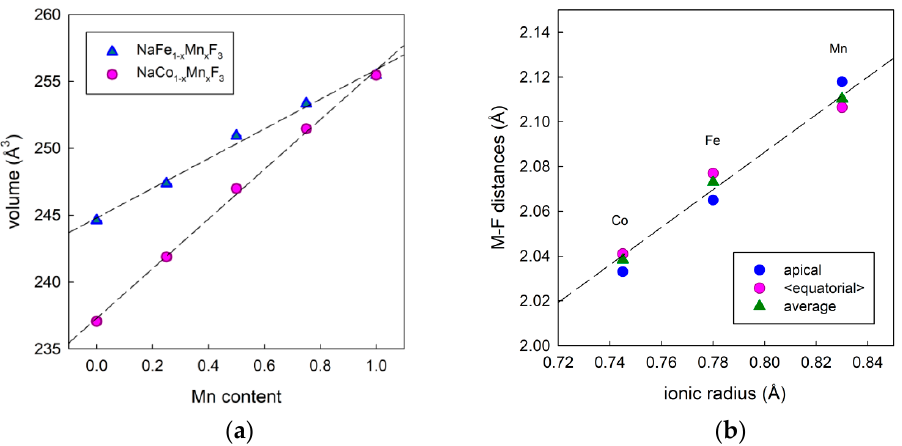
average equatorial M − F bond lenghts increase linearly with the ionic radius (Figure 5b), as expected.